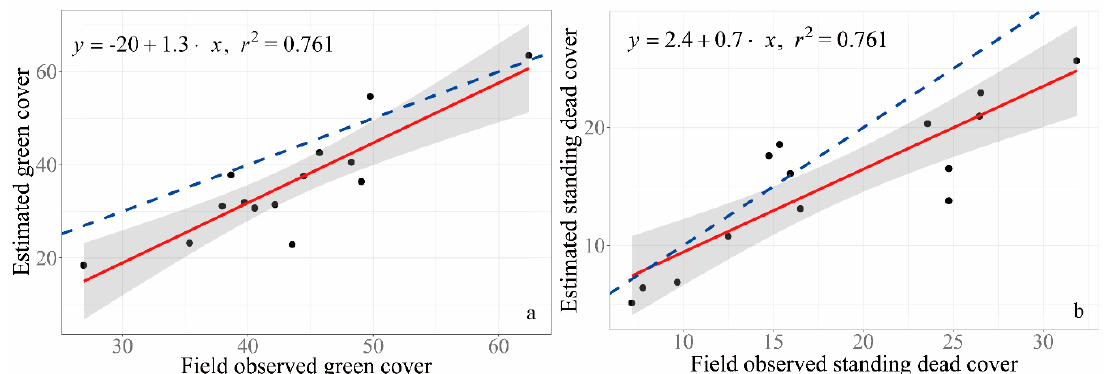
Figure 4. Comparing estimated green and dead cover with field observed cover (the red solid line is the regression line; the blue line is 1:1). ( a ) Comparison between green vegetation (GV) cover from visual estimation (i.e., field observed green cover) and that from GV extraction by the method developed in this study. ( b ) Comparison between SDM from visual estimation (i.e., field observed standing dead cover) and that from SDM extraction from the method of this study.